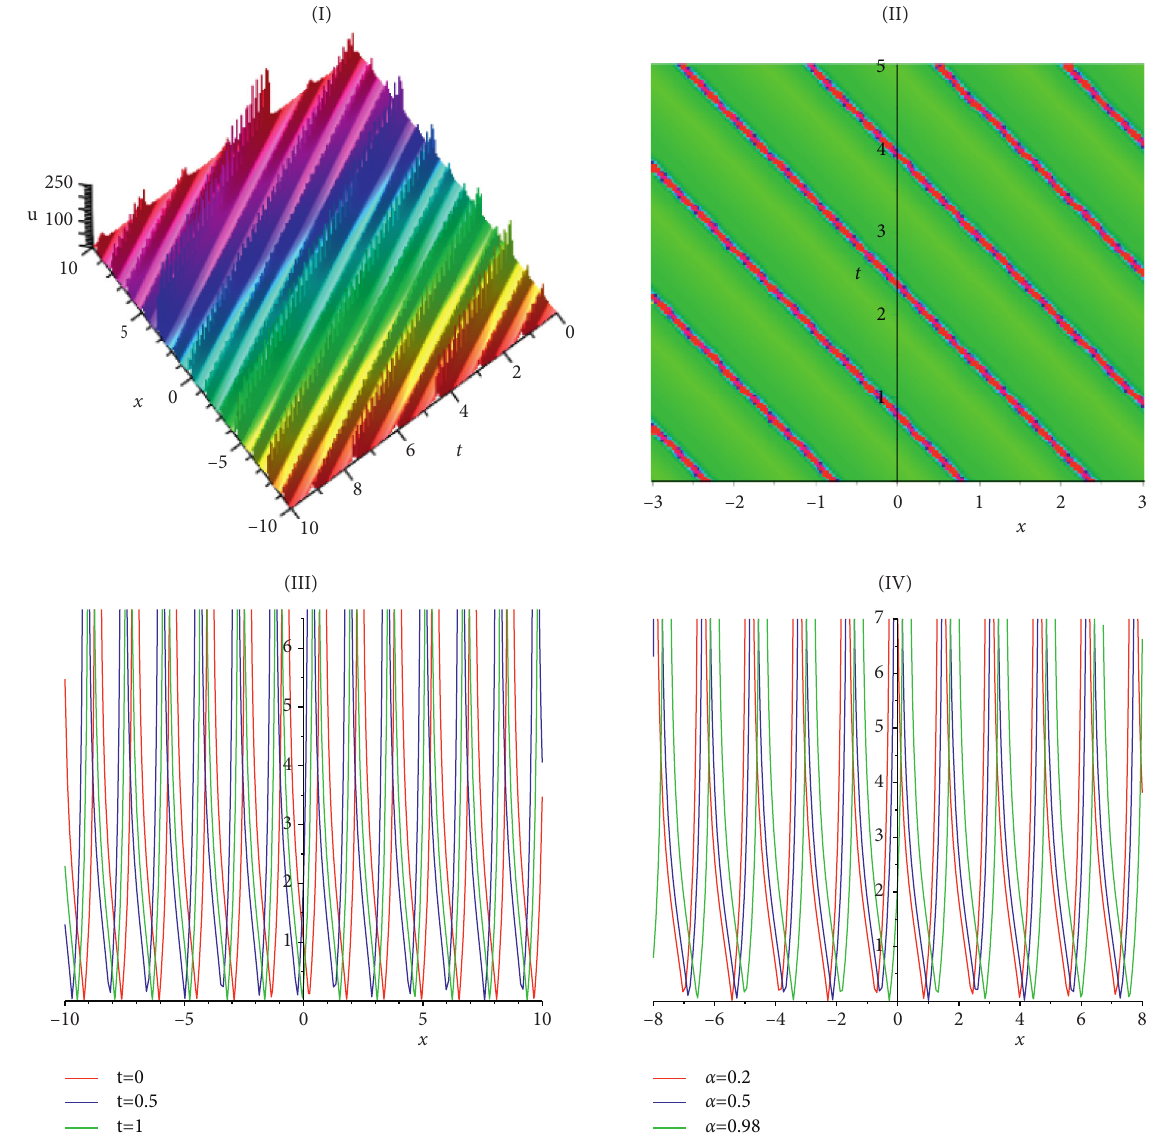
Figure 5: Evolution of the periodic solution (24) with data r � , k